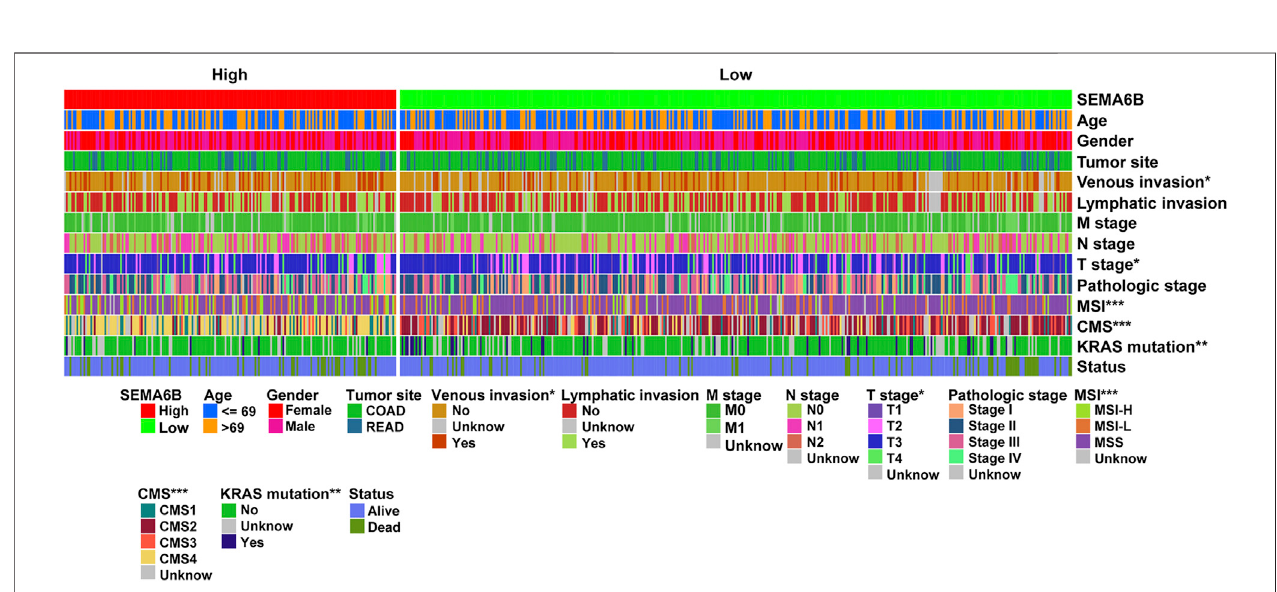
FIGURE 2 | Cluster heatmap of correlations between SEMA6B and molecular subtypes in the TCGA dataset. The relationships between SEMA6B level and each clinicopathological characteristic were measured with the χ 2 test. * p < 0.05, ** p < 0.01, and *** p < 0.001.